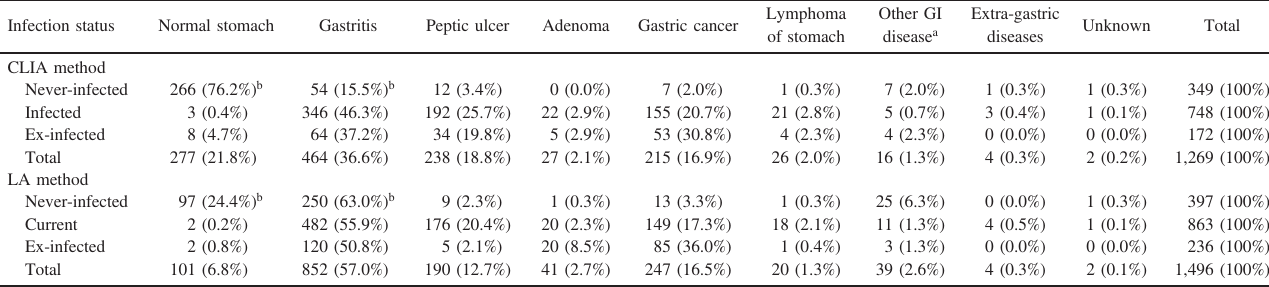
Table 2. Clinical diagnoses of the subjects used in the analyses Infection status